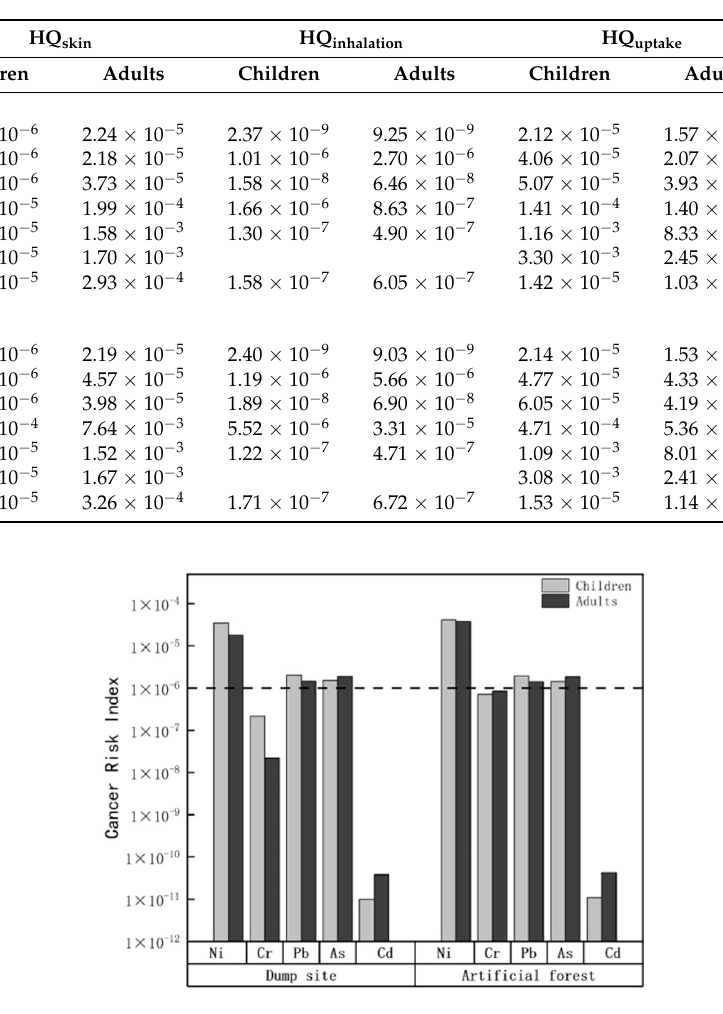
Table 4. Soil heavy metal non-carcinogenic risk index.